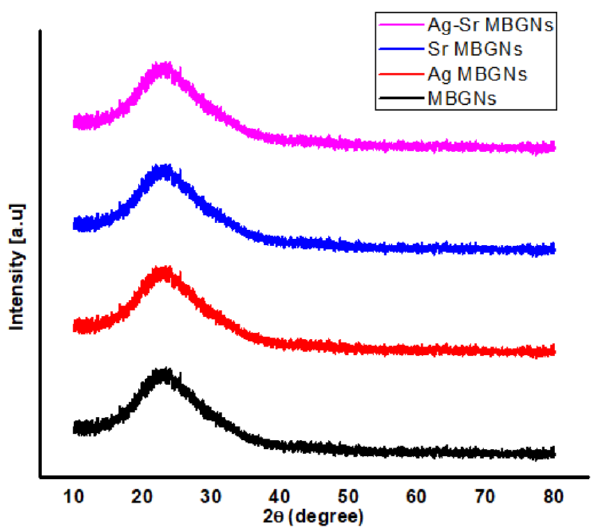
Figure 5. X-ray diffraction (XRD) patterns of Ag-Sr-, Ag-, and Sr-doped MBGNs. 2.3. Zeta Potential The zeta potential measurements of MBGNs, Ag MBGNs, Sr MBGNs, and Ag-Sr MBGNs were performed in ethanol, and the results are given in Table 1. It was